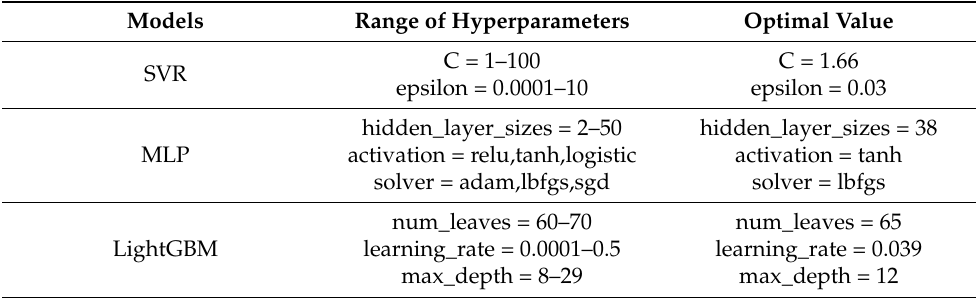
Table 2. Optimal hyperparameters of SVR, MLP, and LightGBM models. Models Range of Hyperparameters Optimal Value C = 1–100 SVR